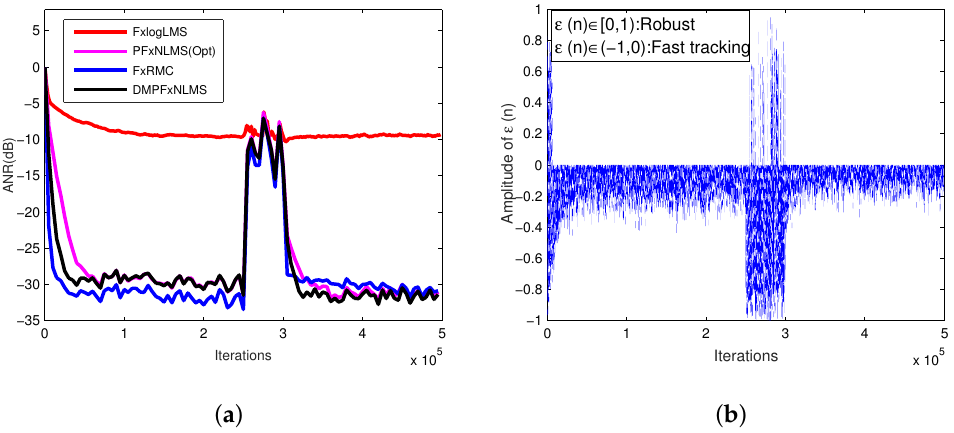
Figure 6. Performance comparison when impulsive interference α = 1.7 ( a ) ANR curves; ( b ) changing process of ε ( n )